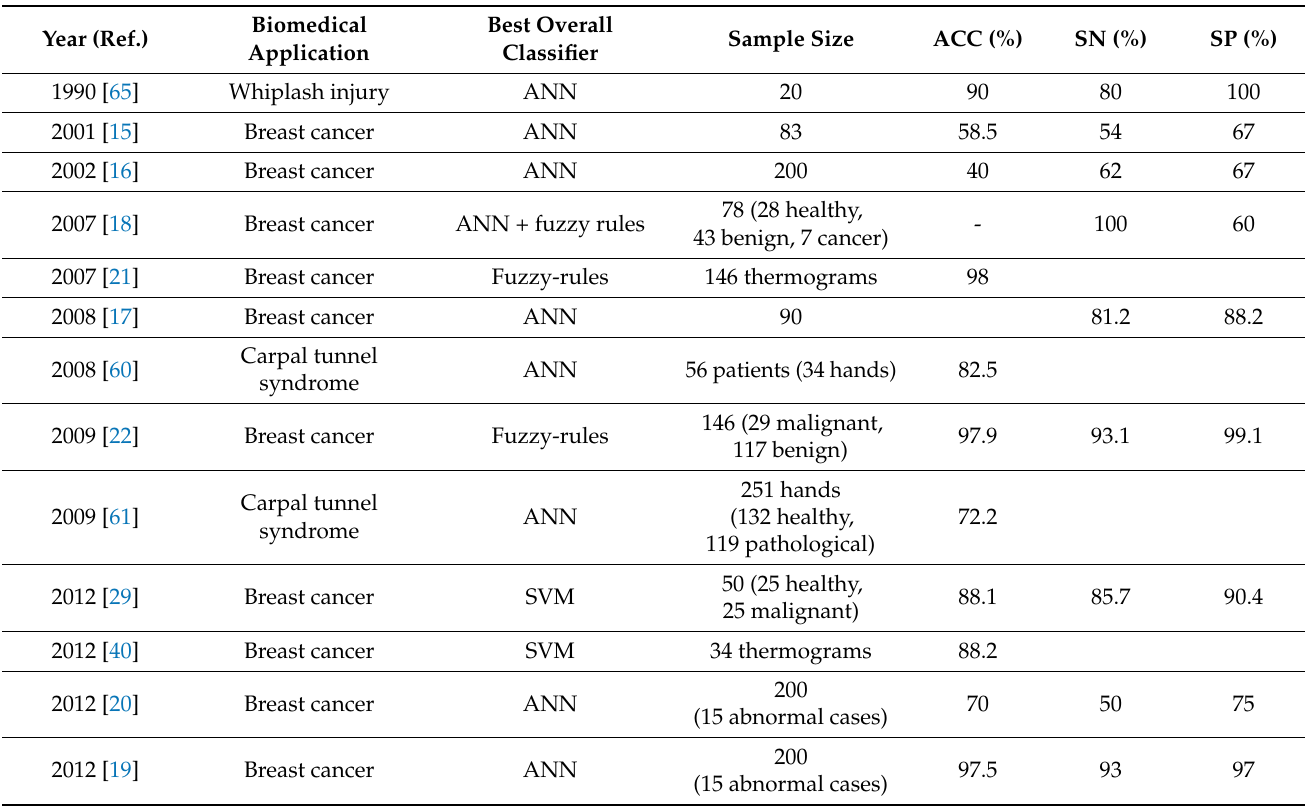
Table A1. Biomedical thermal applications and respective implemented base classifier, sample size, accuracy (ACC), sensitivity (SN) and specificity (SP), chronologically ordered from oldest to latest. Year